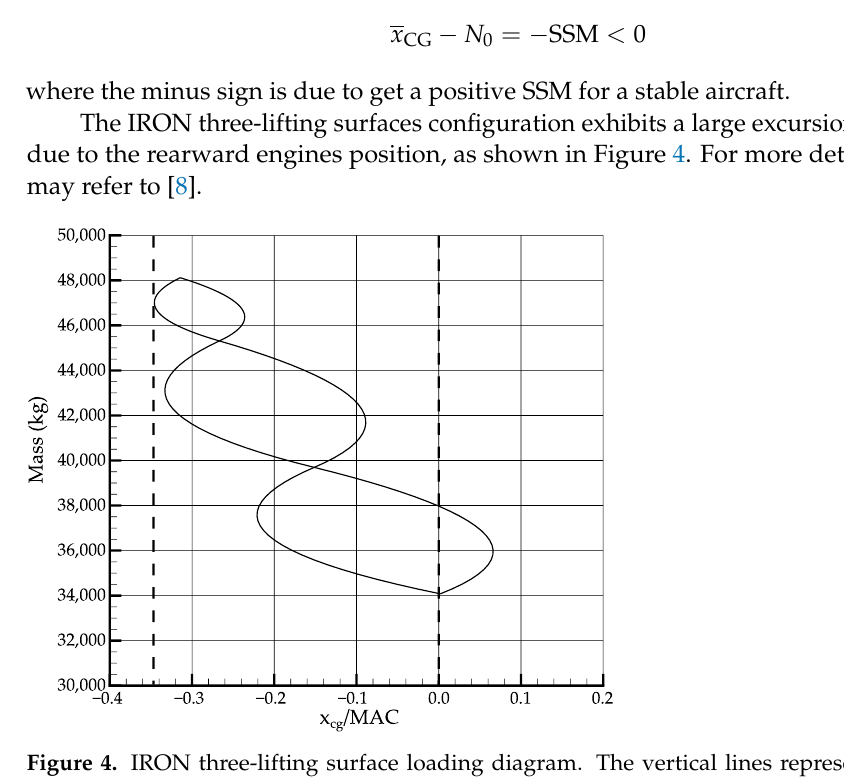
Figure 4. IRON three-lifting surface loading diagram. The vertical lines represent the imposed constraints to the CG excursion to limit the horizontal tailplane size